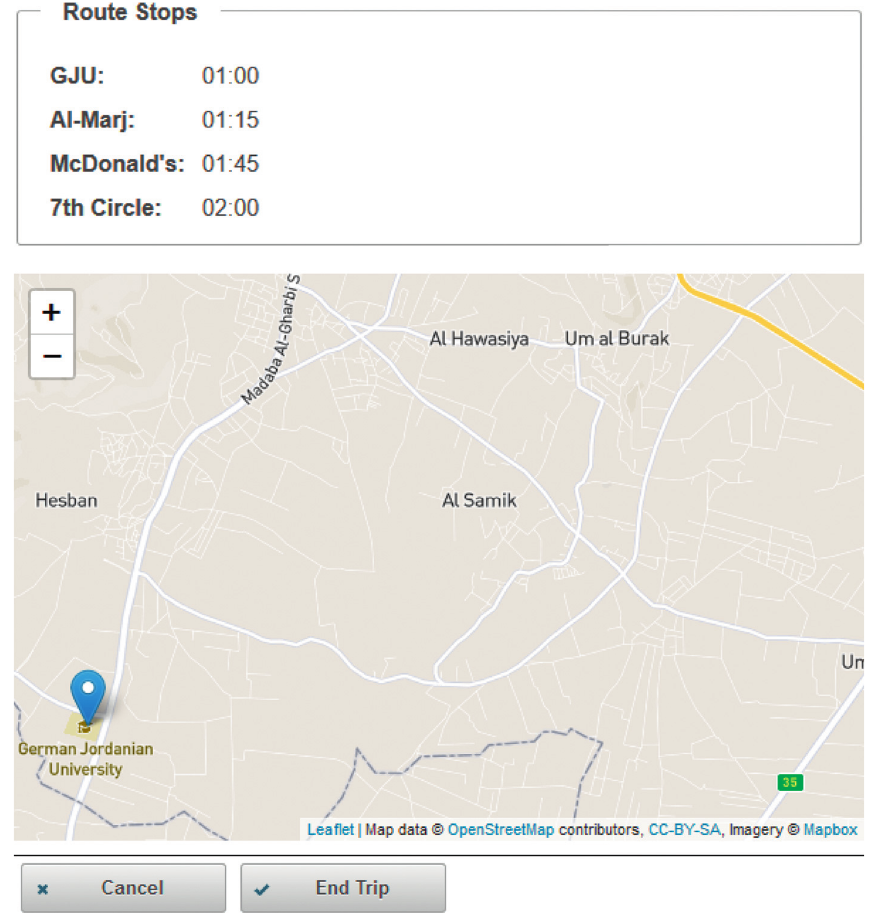
Figure 8: The manage trip screen in the driver view.